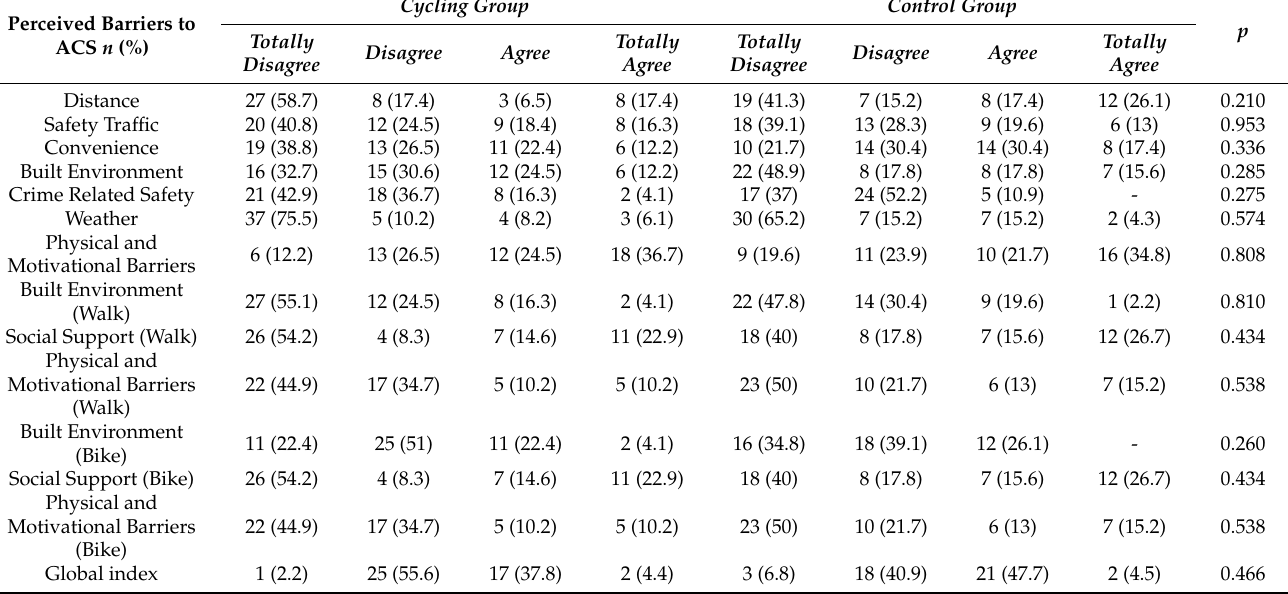
Table 2. Descriptive data of perceived barriers by intervention group at baseline.